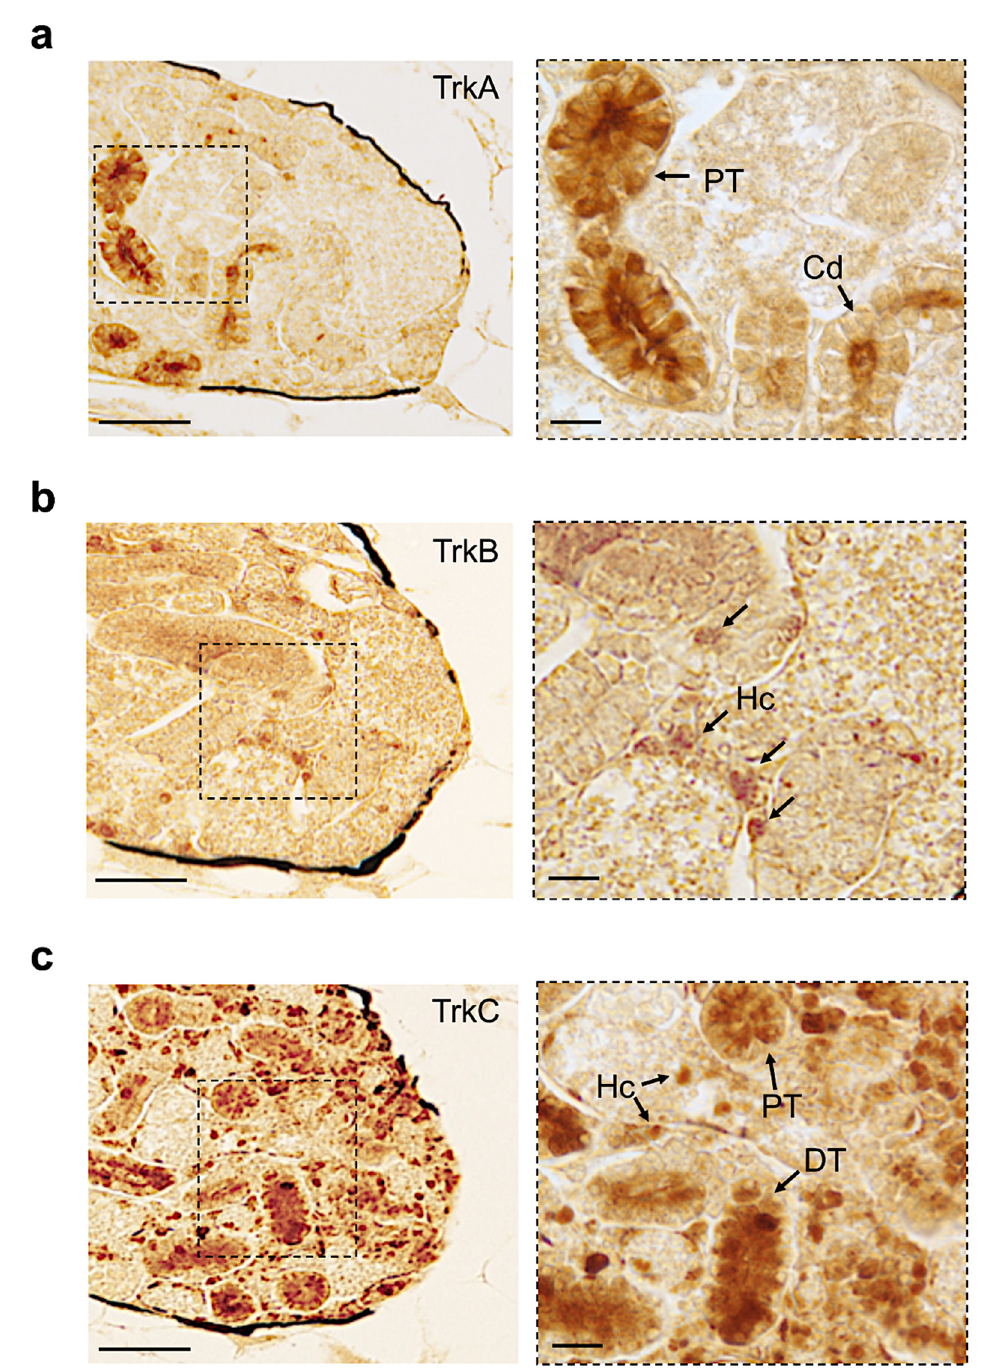
Figure 8. Immunohistochemistry to detect TrkA, TrkB, and TrkC on paraffin sections of adult zebrafish kidney. ( a ) All receptors are expressed in adult zebrafish kidney in different regions. TrkA is expressed in the collecting duct and proximal tubule. ( b ) TrkB is detected in hematopoietic cells. ( c ) TrkC protein is abundantly distributed in different regions: hematopoietic cells; distal and proximal tubules (Hc, DT, and PT). Scale bars: 200 µm and 50 µm ( a – c ).